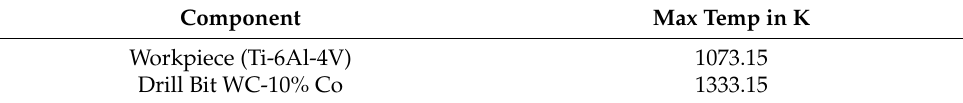
Table 7. Maximum Temperature attained by the cutting tool & workpiece [45,46].